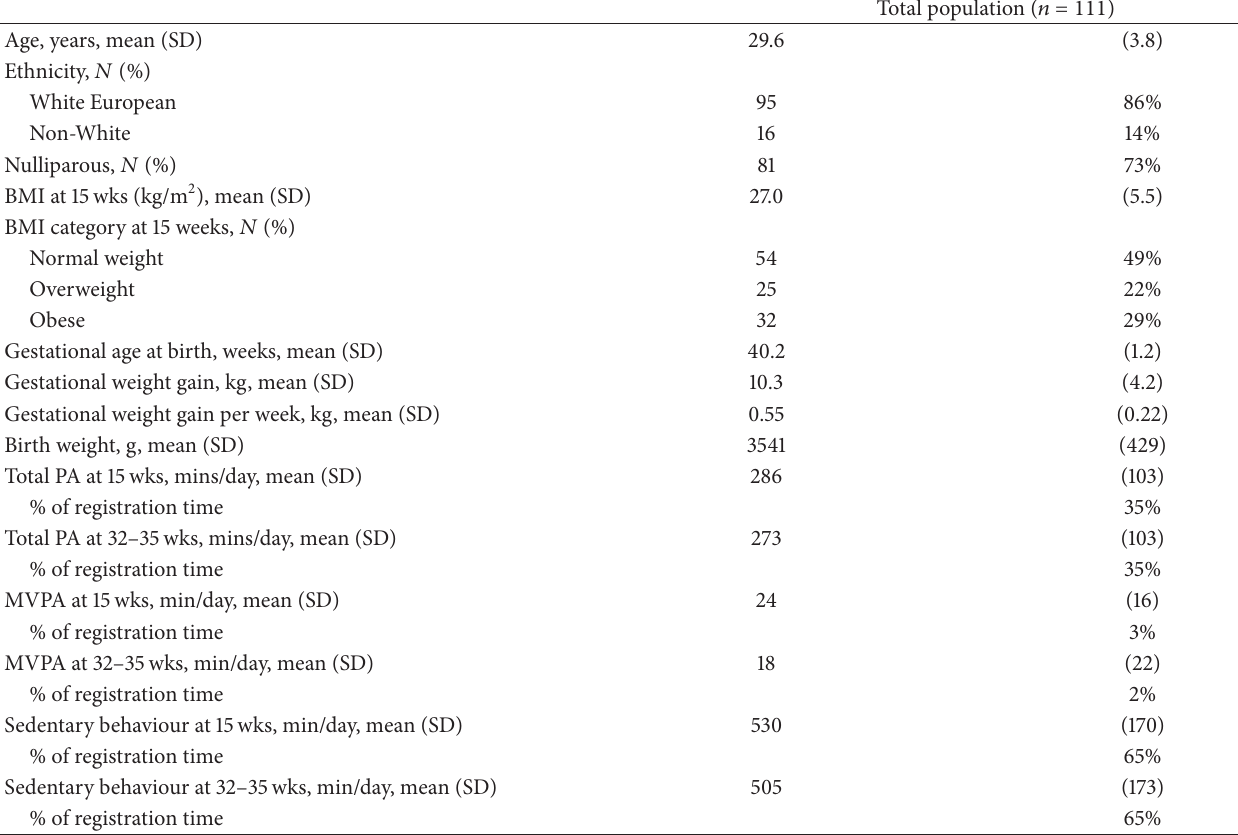
Table 1: Characteristics of the study sample.